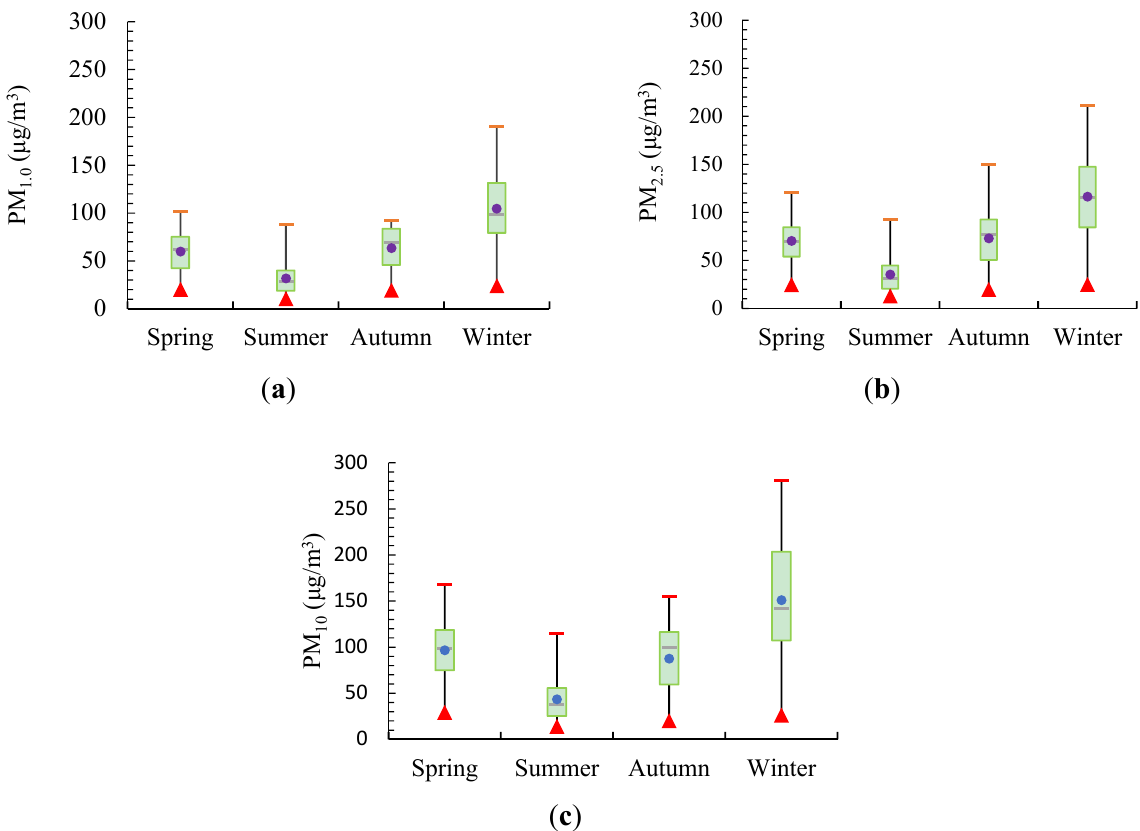
Figure 3. Seasonal characteristics of PM 1 ( a ), PM 2.5 ( b ), and PM 10 ( c ) mass concentration. The purple dot represents the mean value of PM in each season and the box represents the twenty-fifth and seventy-fifth percentiles (upper and lower edges of box); the short red horizontal line represents the maximum; the red triangle represents the minimum, and the horizontal green line shows the median value of PM in each